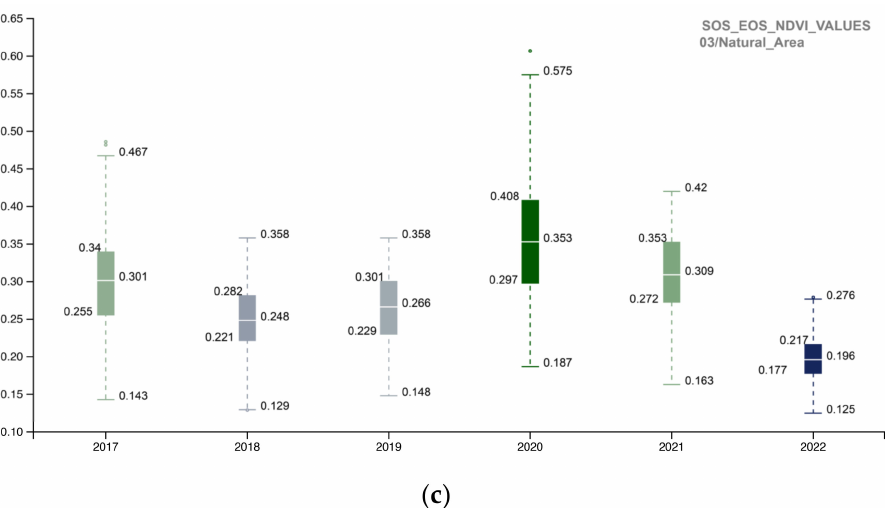
Figure 11. The boxplot summarizes and compares the NDVI SOS-EOS quantitative distribution for